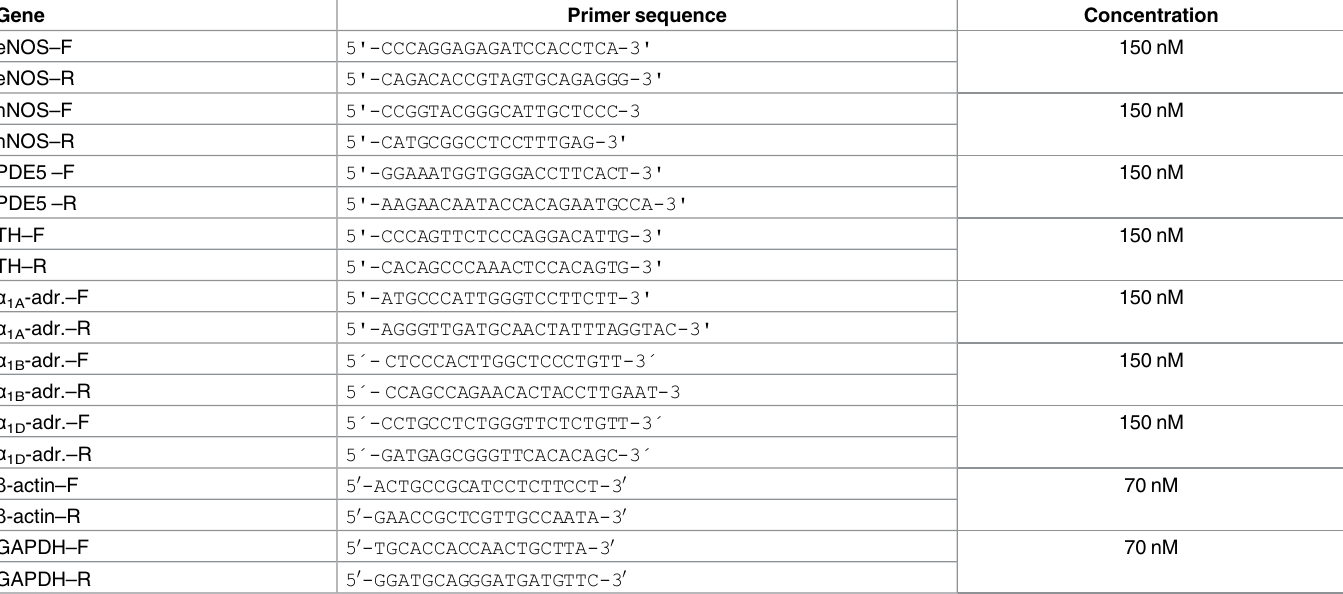
Table 1. Sequences and ideal concentrations for the primers used in